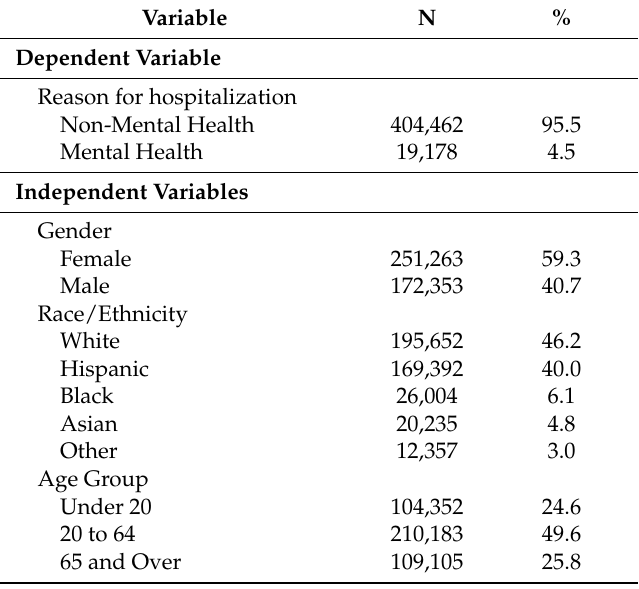
Table 1. Characteristics of hospitalized